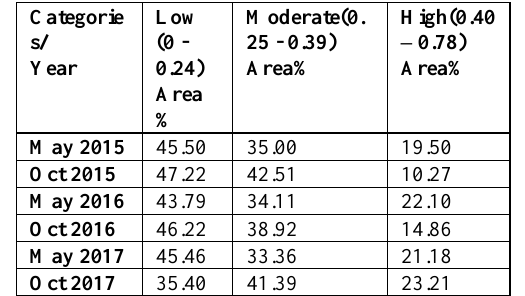
Fig.5. NDVI Categories over the years in Jodhpur